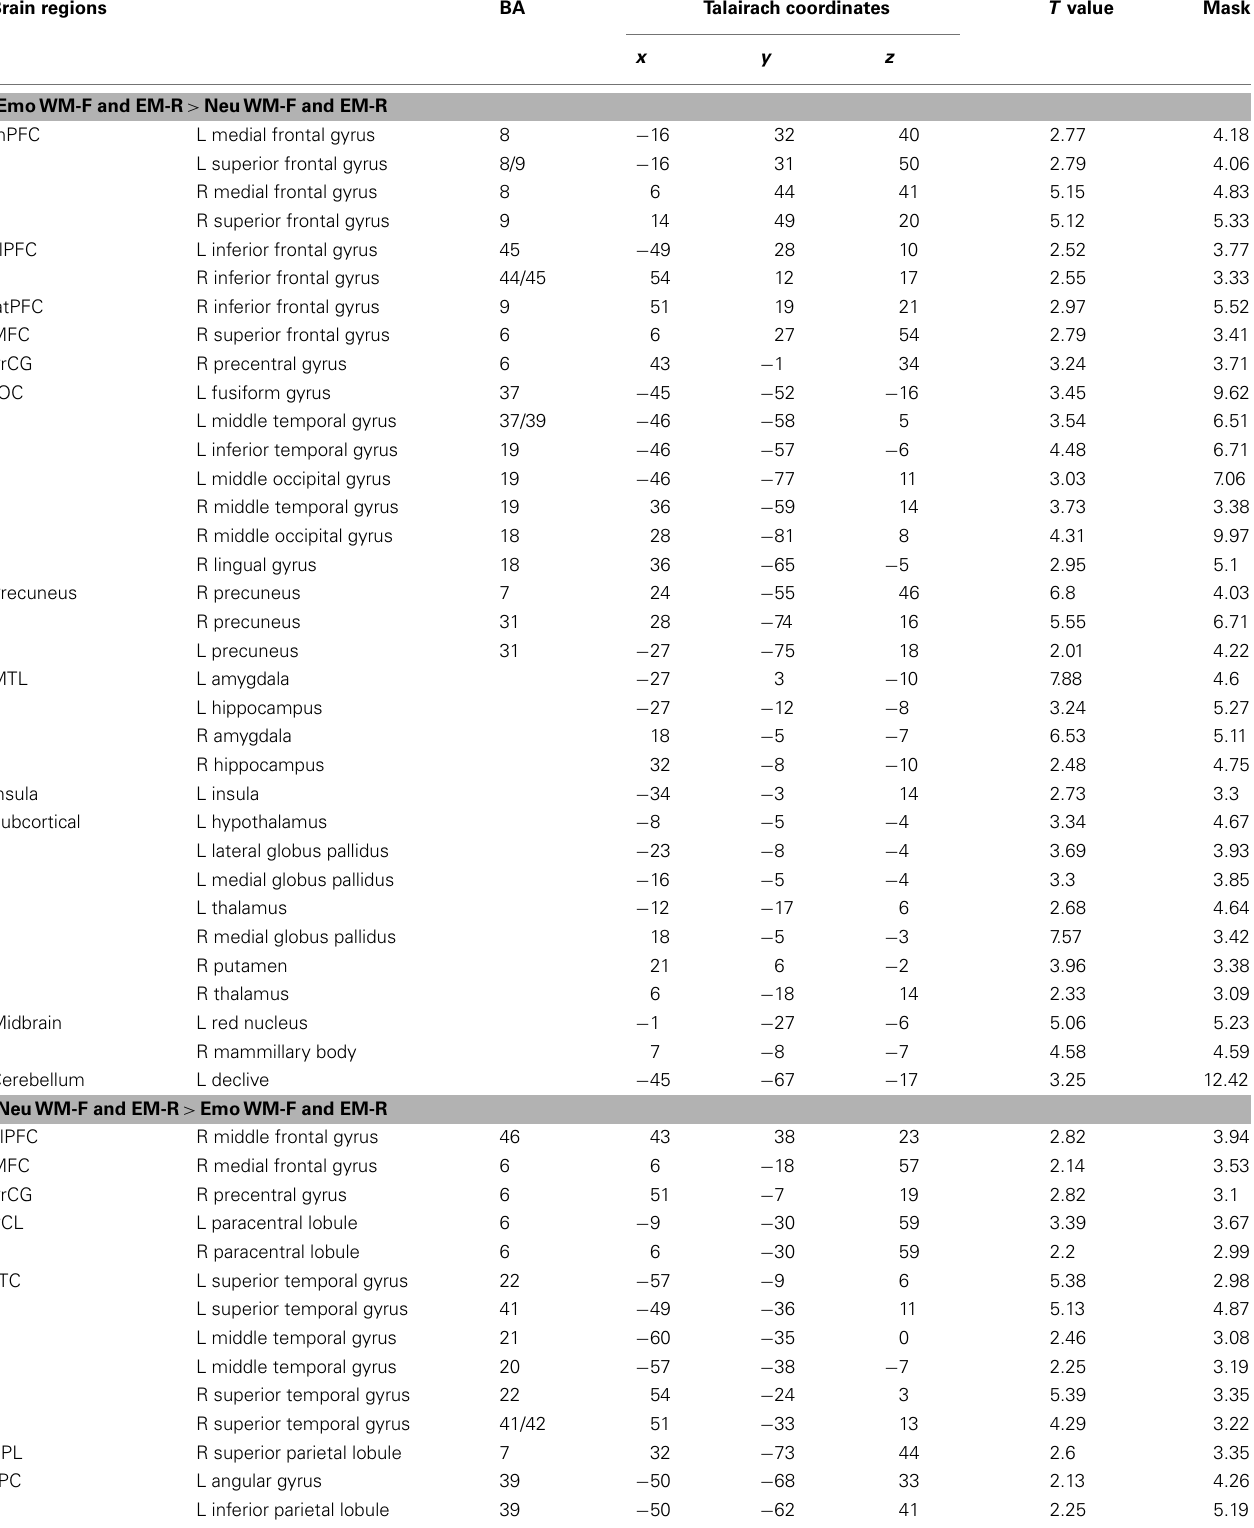
Table 1 | Opposing effects in ventral affective and dorsal-executive neural systems linked toWMI and EME effects of emotion. Brain regions BA Talairach coordinates